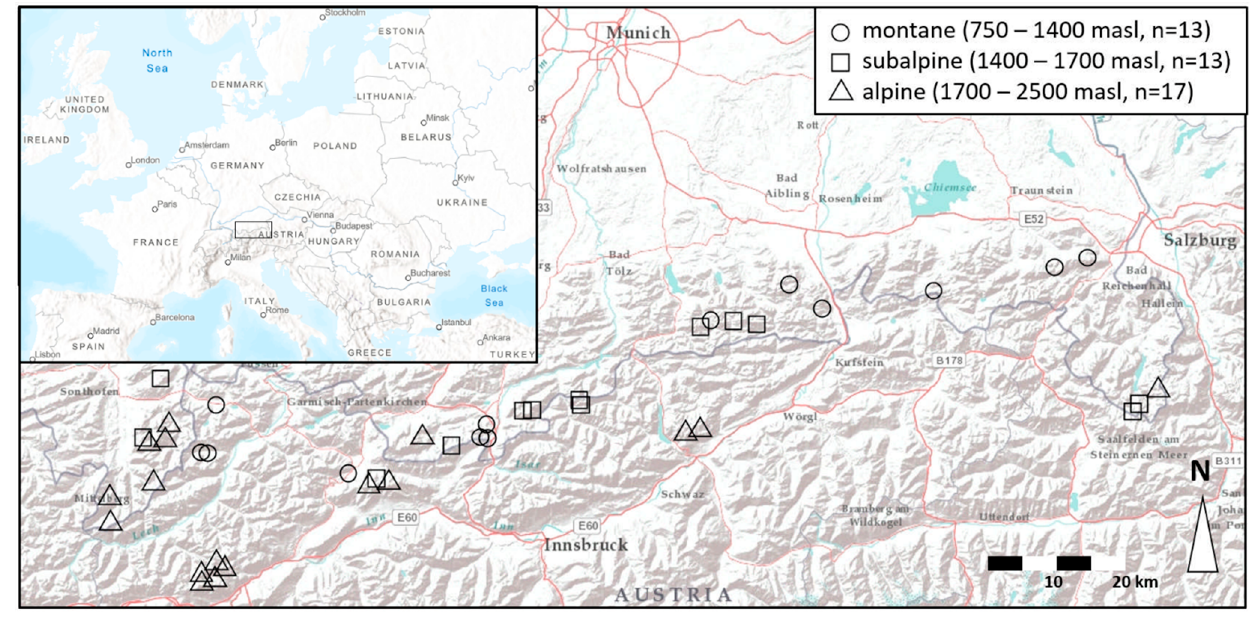
Figure 1. The 43 study lakes are spread across the Bavarian and Tirolian Alps in Germany and Austria, spanning a longitudinal gradient of c. 220 km and a latitudinal gradient of c. 50 km.